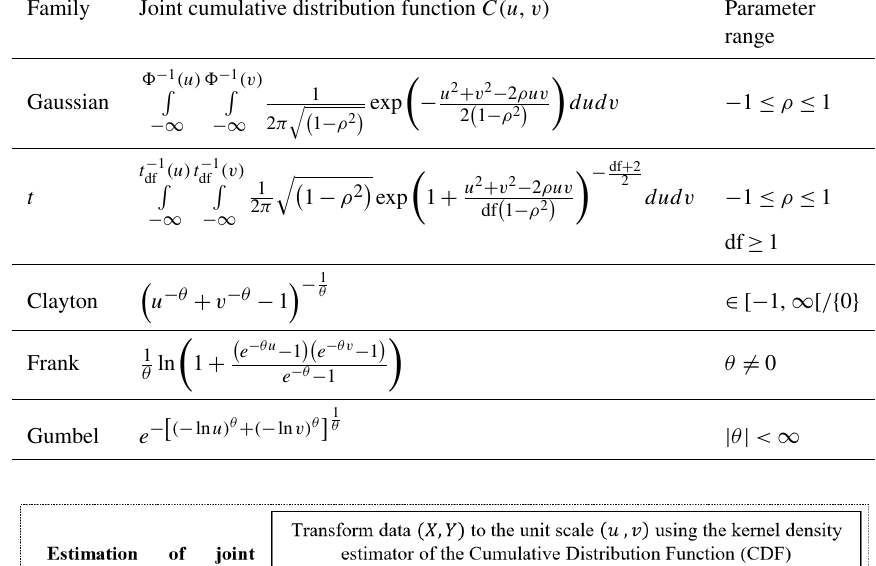
Family Joint cumulative distribution function C(u , v) Parameter